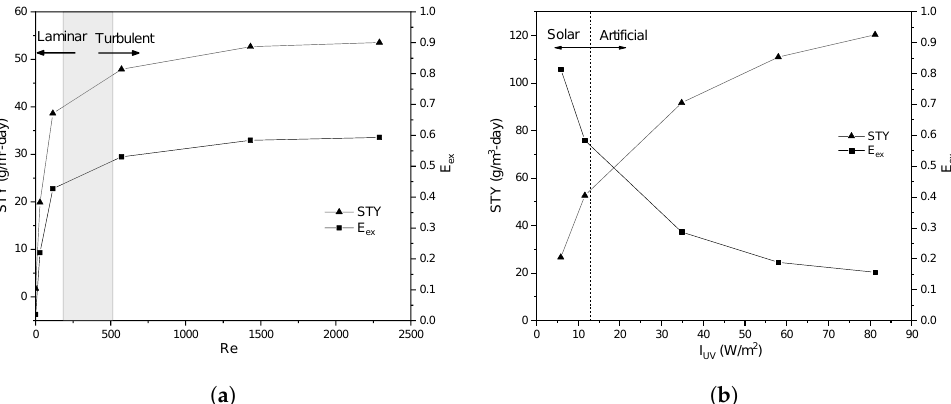
Figure 15. Space–time yield maximisation by ( a ) hydrodynamic regime at a constant superficial radiation intensity (11.6 W/m 2 ) and ( b ) superficial radiation intensity at a constant flow velocity (0.05